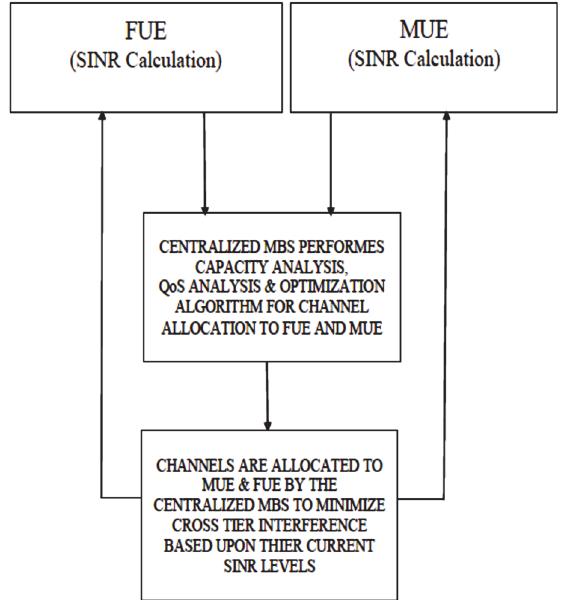
Fig. 5. Block diagram of channel